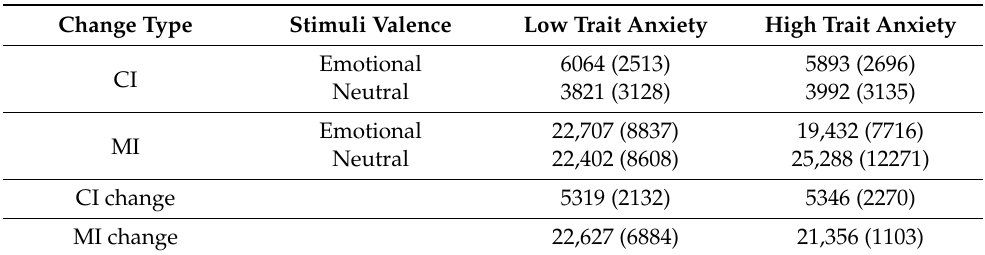
Figure 3. Mean and Std.Err of the interaction Group × Type of Change × Emotion. CI: Central interest changes; MI: Marginal interest changes; LTA: Low trait anxiety group; HTA: High trait anxiety group. Table 2. Performance (RTs mean and standard deviation) in the emotional flicker task considering emotional vs. neutral stimuli.